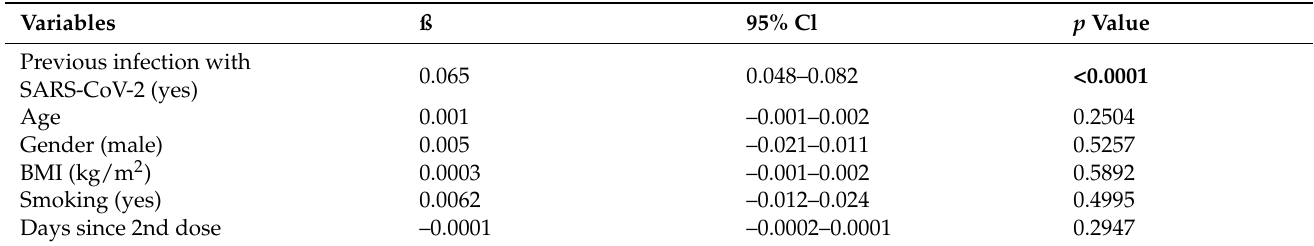
Table 3. Multivariate Linear Regression for IgG Levels in